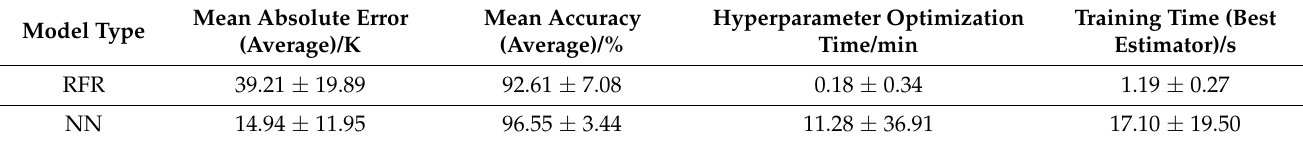
Table 6. Summary of typical data characterizing the accuracy and time-efficiency of random forest regressor and neural network models in this study. The term average indicates that values are an average of those for T TC,1 and T TC,2 . The values in the table represent averages obtained using 19 datasets as described in Table